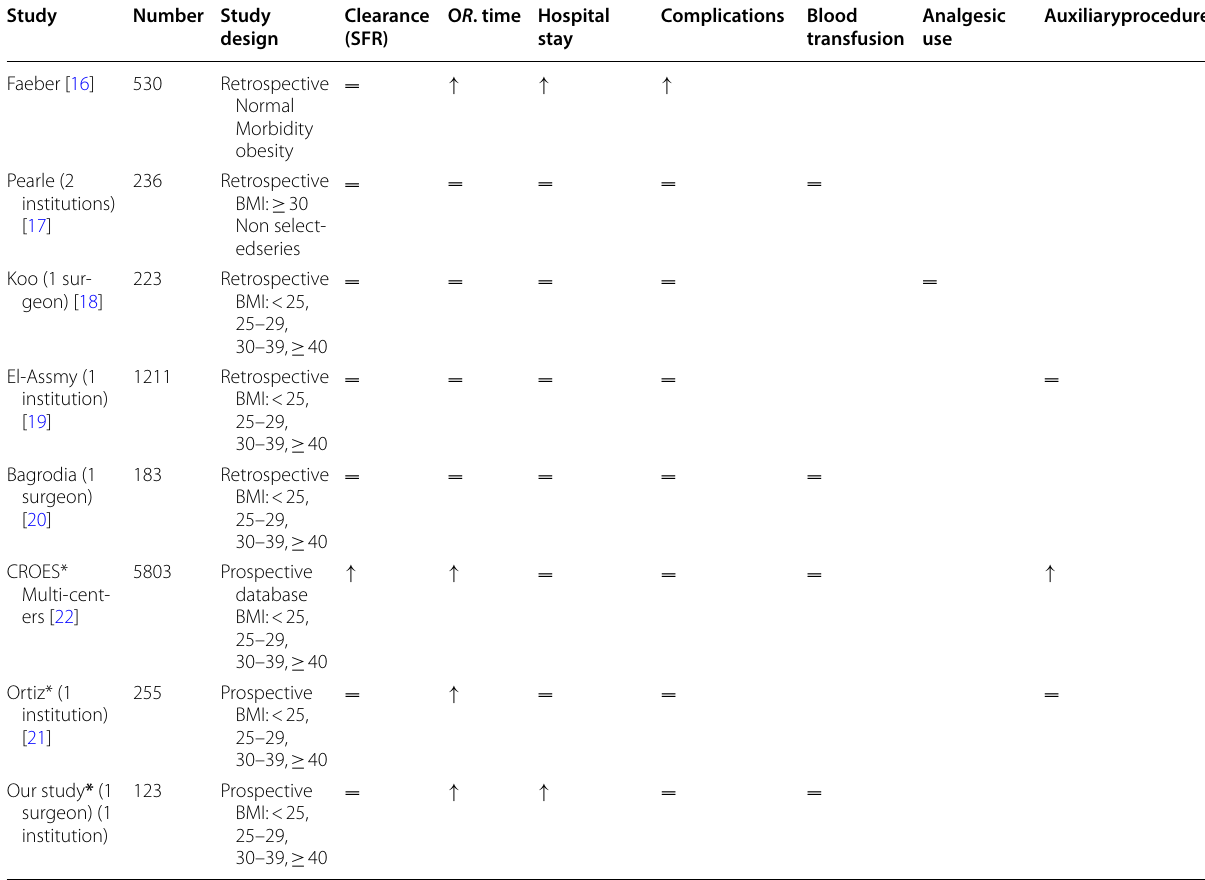
Table 5 Summary of effect of body mass index in percutaneous